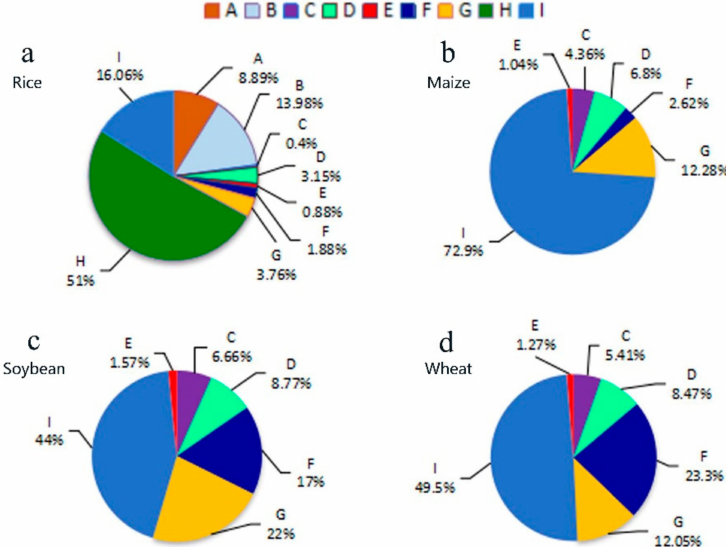
Figure 5. Composition of CFs based on crop structure in the HLRA. (Average of the years 2001–2015). A: Plastic film; B: Electricity; C: Pesticide; D: P fertilizer; E: K fertilizer; F: Seed; G: Diesel; H: CH 4 ; I: N fertilizer + N 2